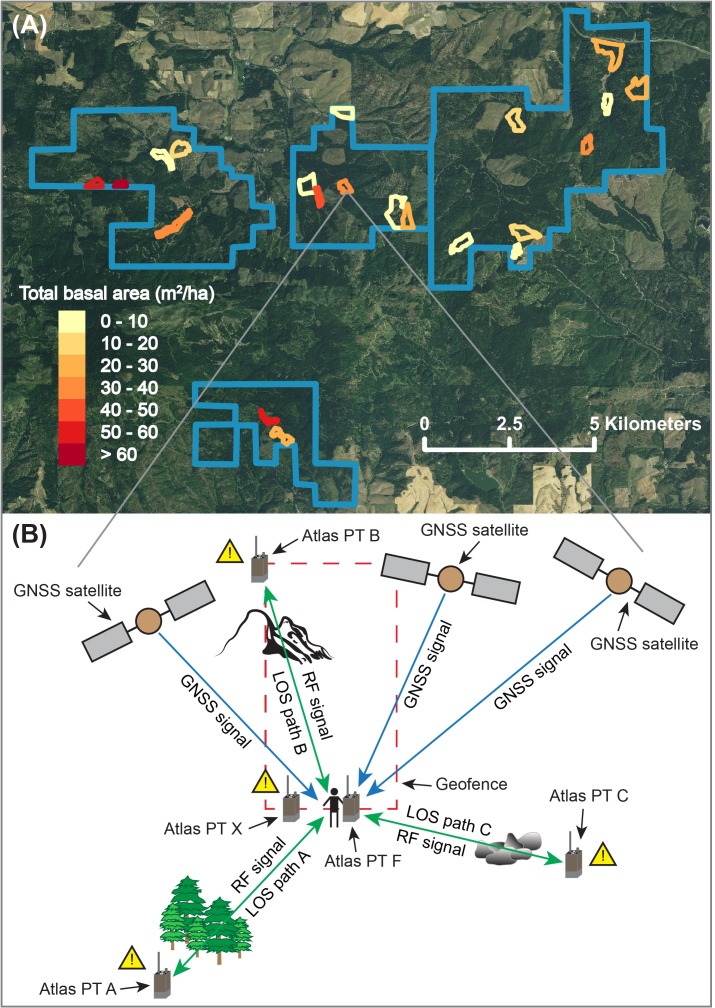
Map of the stand locations on the UIEF and illustration of the experimental setup.(A) The 21 stands are delineated according to total basal area (m2/ha) and the UIEF unit boundaries are shown in blue. Background map is 1-m NAIP imagery. (B) Illustration of global navigation satellite system (GNSS) technology paired with radio frequency (RF) transmission (GNSS-RF). GNSS-RF transponders (Atlas PTs) receive positional information from GNSS satellites and relay this information to one another using radio frequency transmission. Atlas PT X is located at the geofence intersection point, while Atlas PTs A, B, and C are located at the triangle points A, B, and C, respectively. The manual faller carried a PT attached at the hip (Atlas PT F).